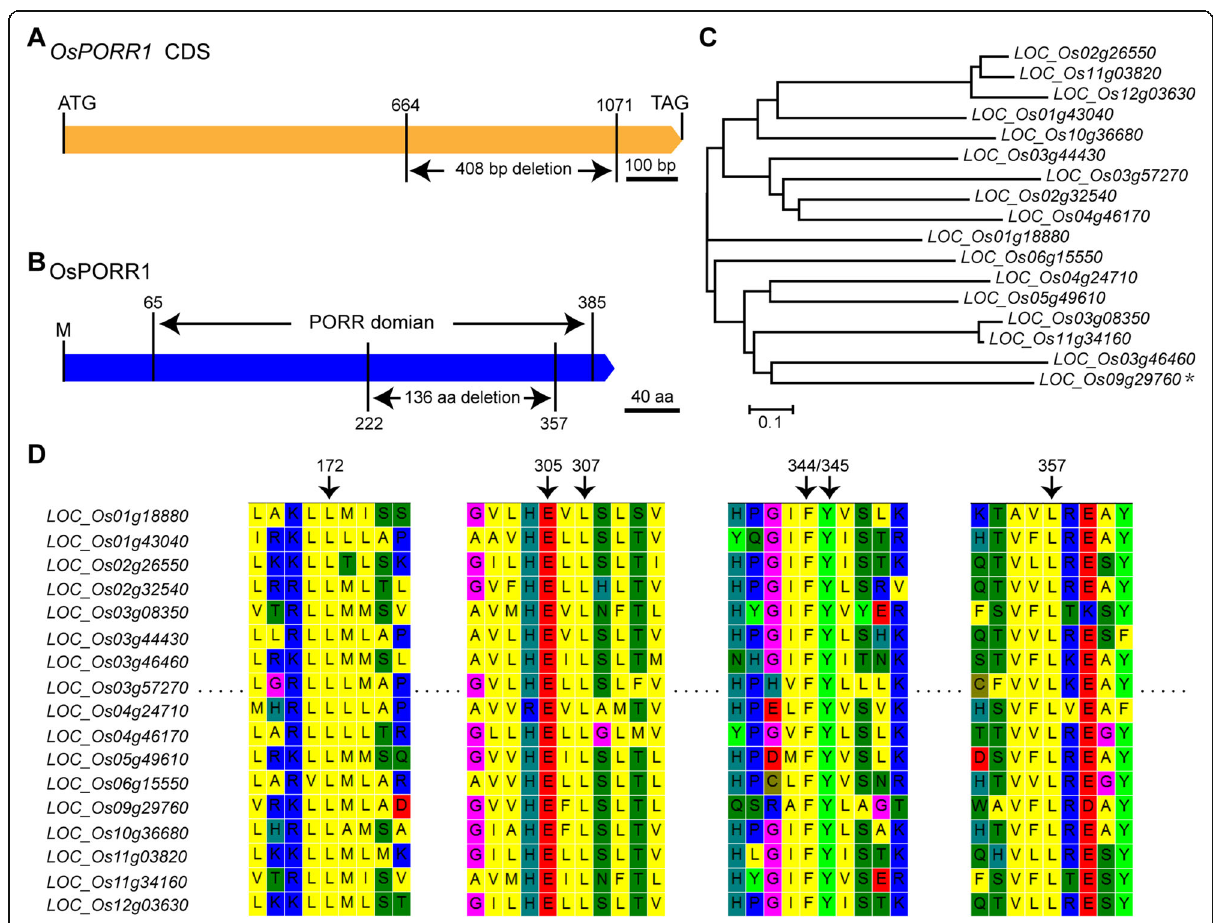
Fig. 4 OsPORR1 domain and its phylogenetic analysis. a Representation of the deleted 408 bp fragment in the 664 – 1071 bp region of the OsPORR1 CDS. b The PORR domain is the 65 – 385 amino acid region of the OsPORR1 sequence. The deleted 136 amino acid fragment is in the region from 222 to 357 aa, within the PORR domain. M, methionine. c Phylogenetic analysis of all PORR family members in rice. The black asterisk indicates OsPORR1 . d Multiple sequence alignment of 17 rice PORR domain-containing proteins. The numbers over arrows represent the positions of six highly conserved aa (Leu 172 , Glu 305 , Leu 307 , Phe 344 , Tyr 345 , and Leu 357